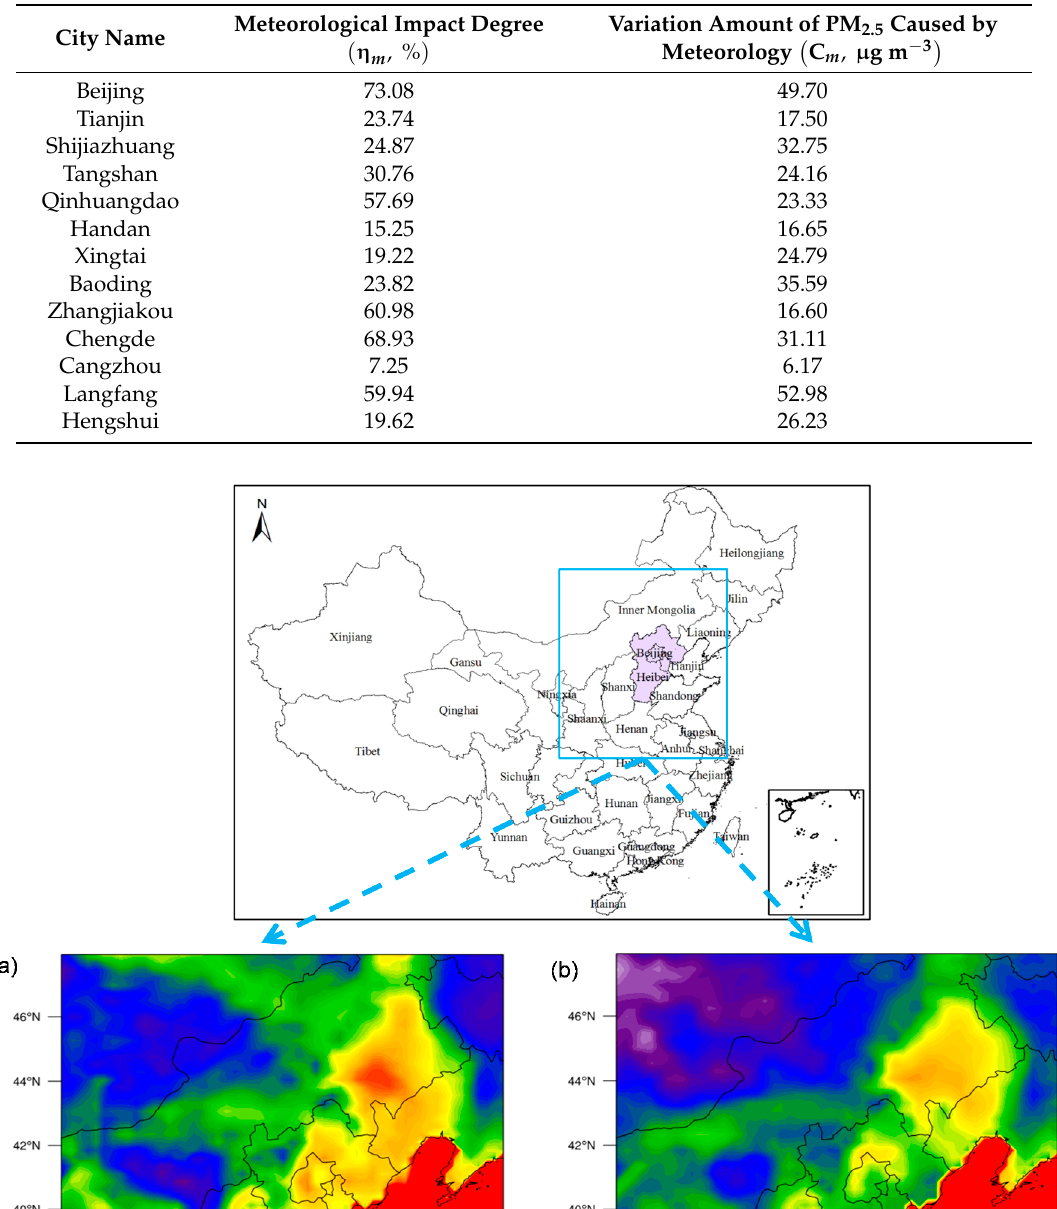
Table 8. Impacts of meteorological conditions on the PM 2.5 pollution in 13 cities in JJJ.